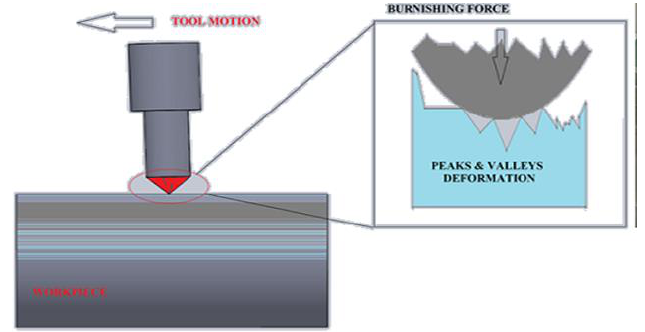
Figure 2. Burnishing mechanism.